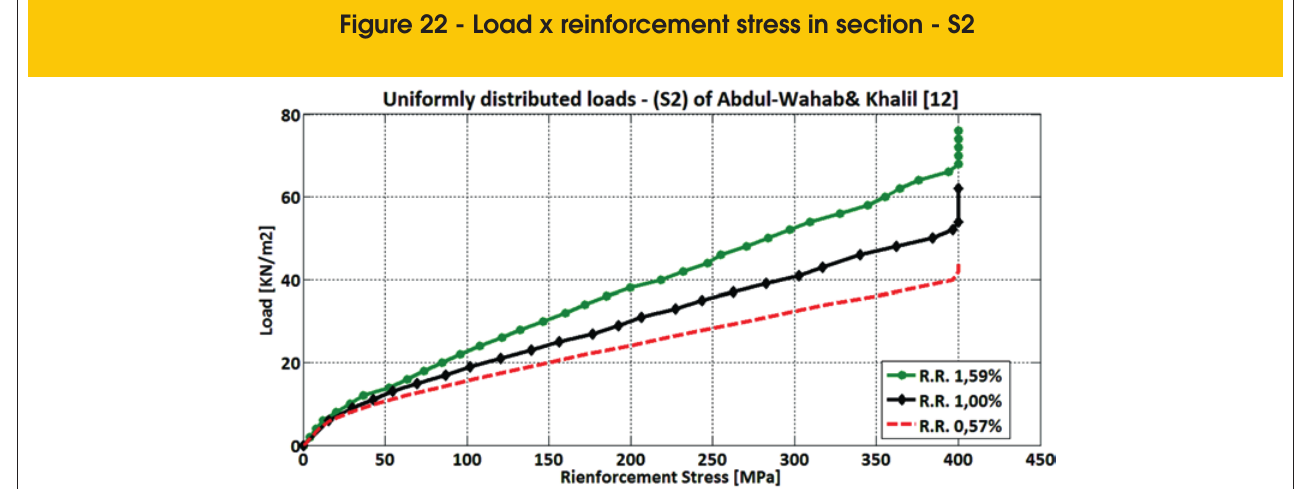
Figure 22 - Load x reinforcement stress in section -